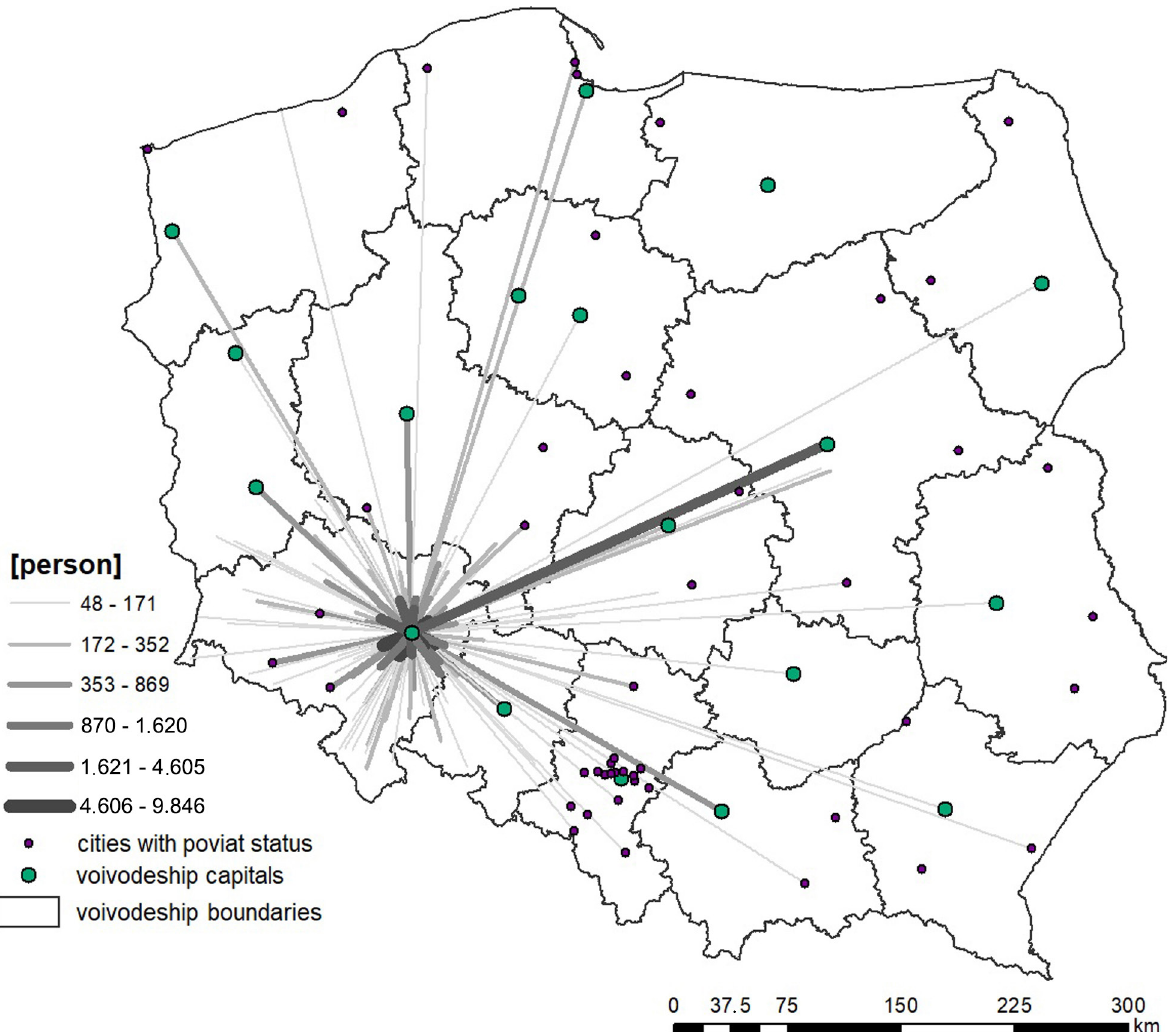
Fig 3. The size of emigration from Wrocław in the years 2002–2018 to municipalities with permanent migration flows.